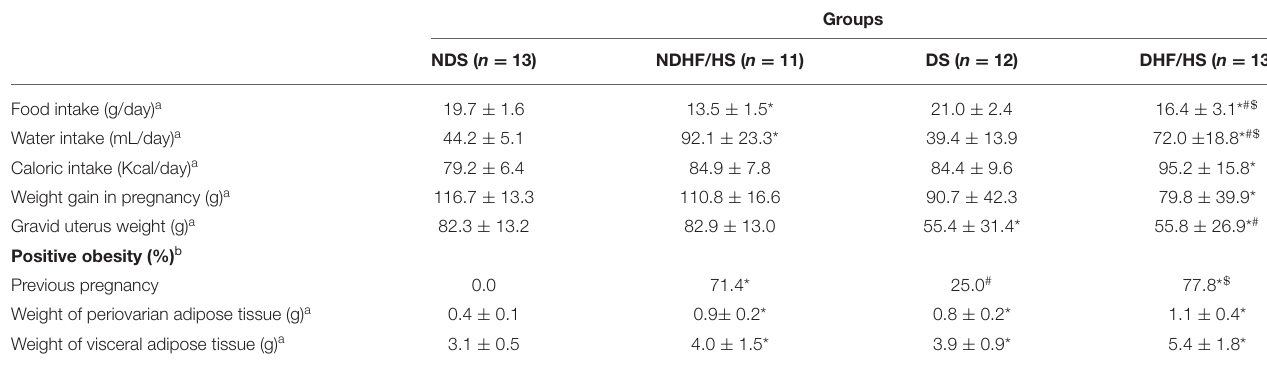
TABLE 2 | Obesity features of non-diabetic (ND) and diabetic (D) rats treated or not (S) with high-fat/high-sugar diet (HF/HS) before and during pregnancy.